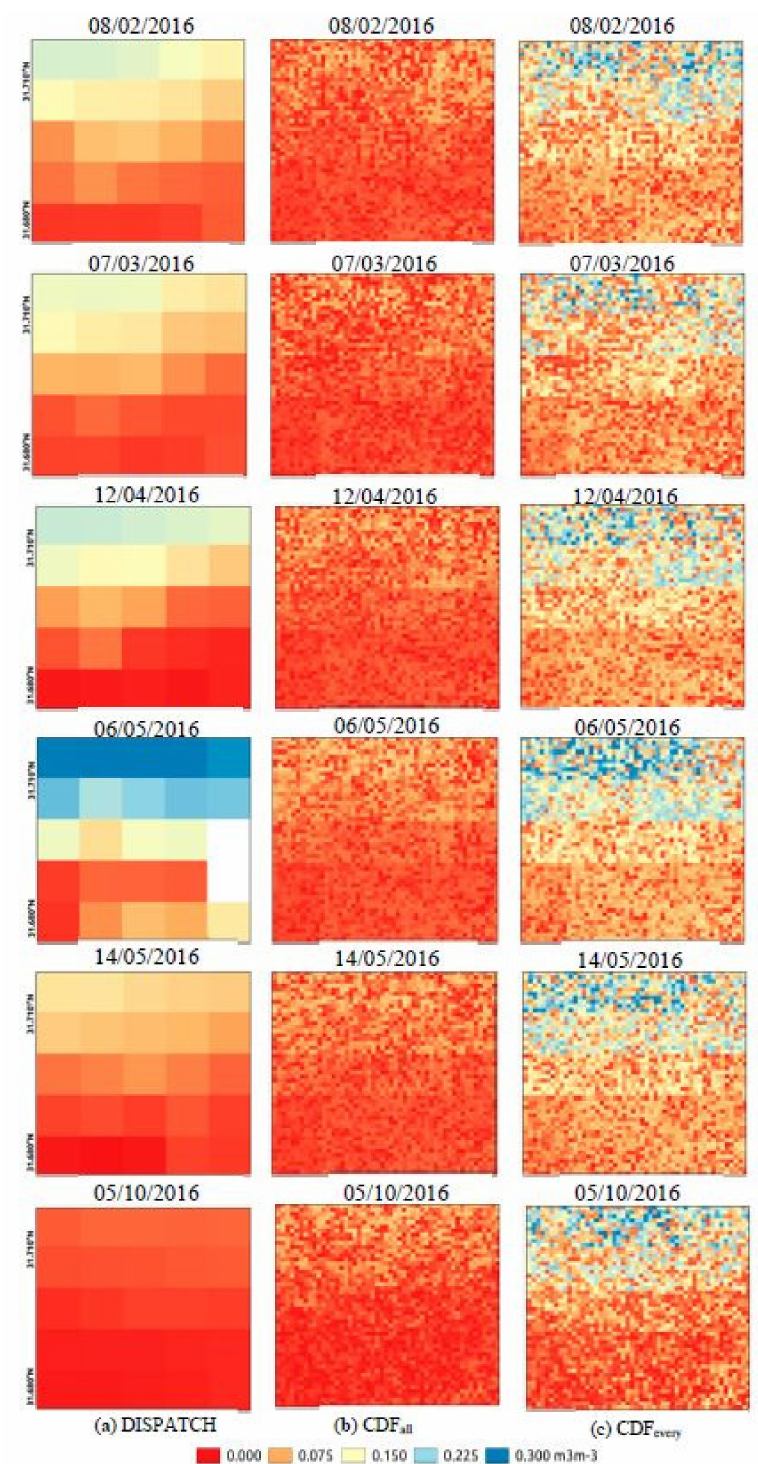
Figure 10. Spatial distribution of the 1 km DISPATCH product and disaggregated soil moisture over of the study area (5 km 2